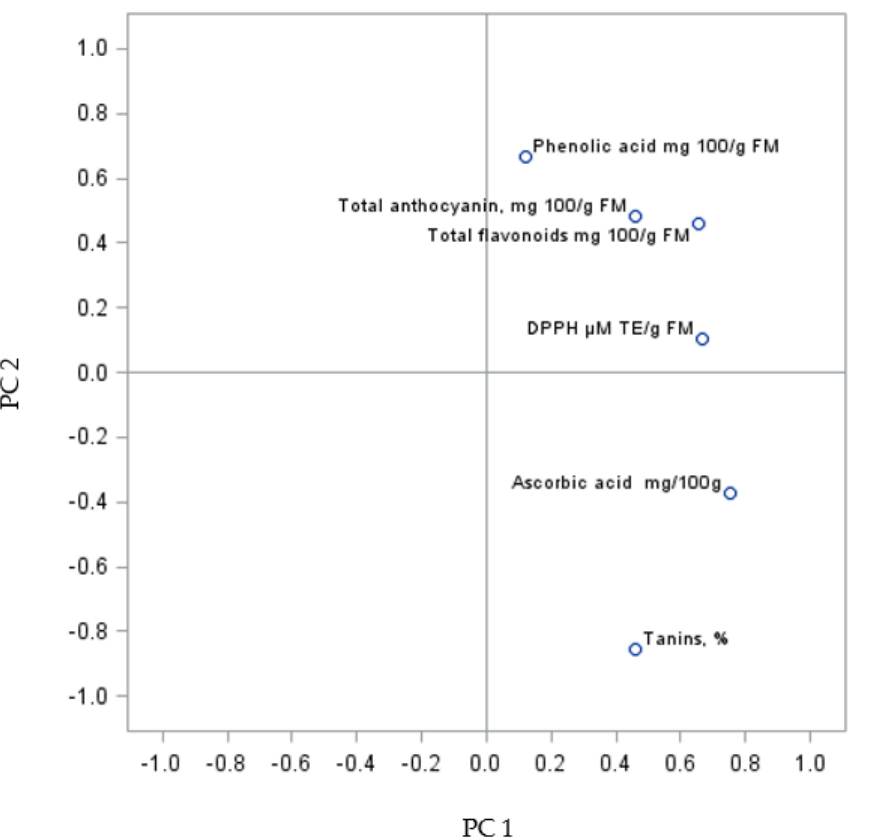
Figure 4. PCA analysis of biologically active compounds in Regent grapevine fruit from shrubs improved on rootstocks. Table 3. Correlation coefficient for yield and quality parameters as well as biologically active compounds of Regent grapevine and their